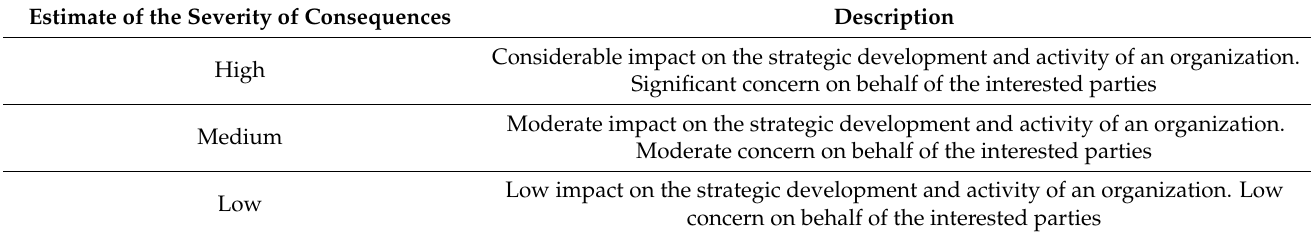
Table 3. Qualitative assessment of event consequences.